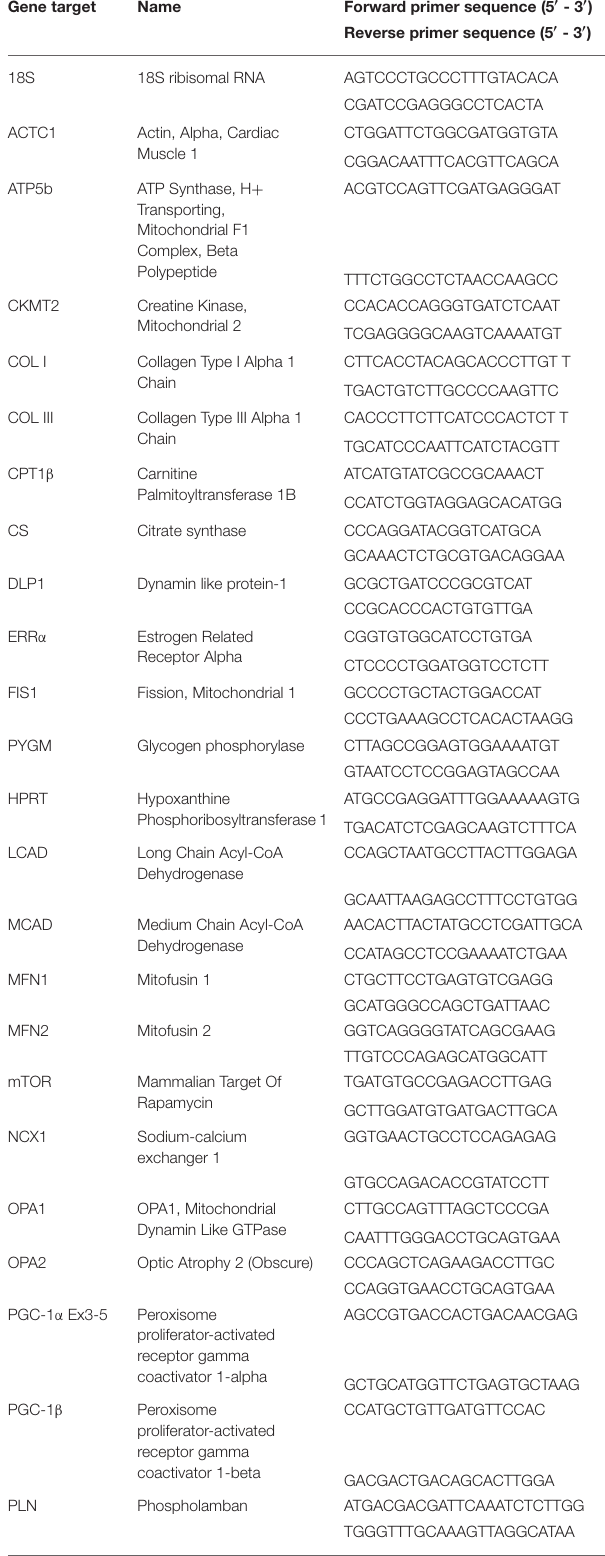
TABLE 1 | Primer pairs for real-time RT-qPCR